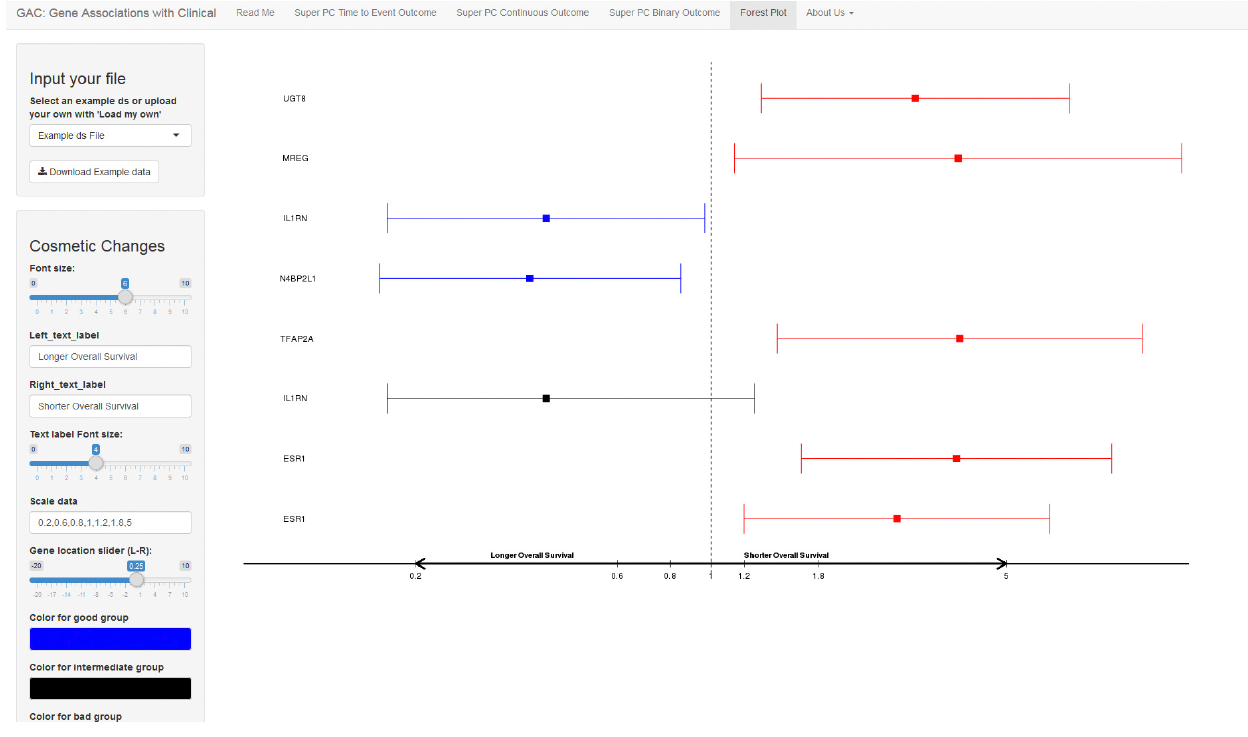
Figure 4. Forest plot. The interface shows an example forest plot. The left side comprises a user menu and the right includes the result plot. Users can upload their own summarized results with hazard ratio and confidence intervals for the survival outcome, or odds ratio and confidence intervals for the binary outcome. For graphical display, the researchers could choose to input different labels, font sizes and